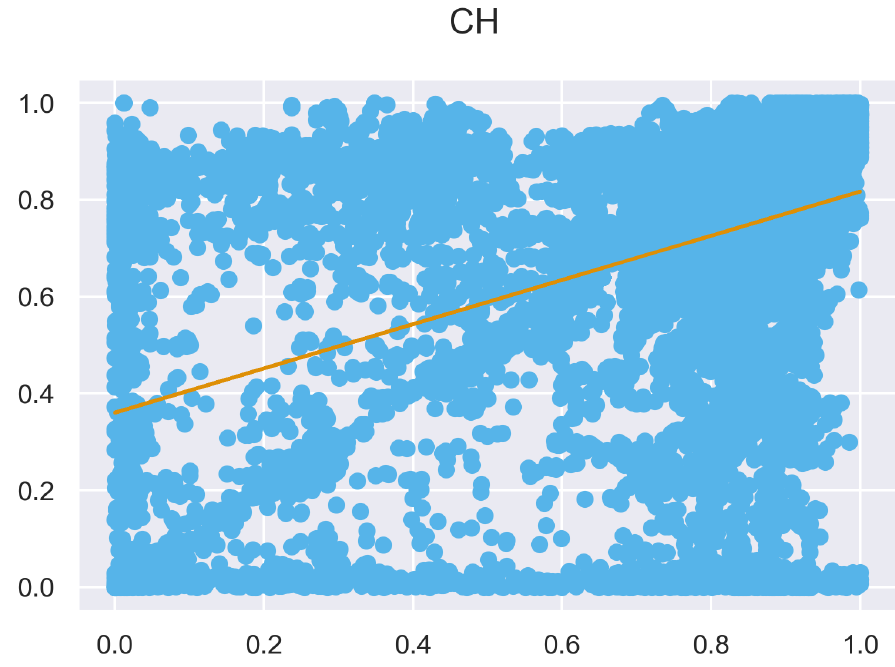
Figure A8. ULS and TLS CH regression at 0.5 m grid